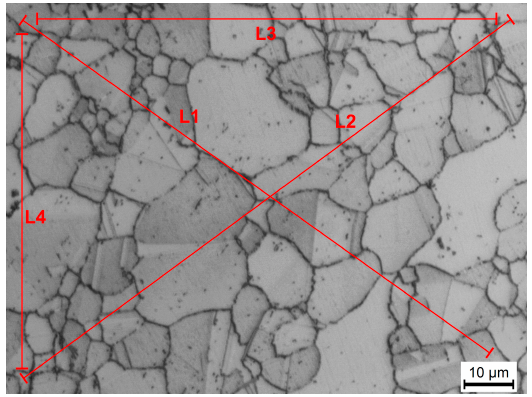
Figure 1. The representative optical microscopy (OM) image of grain size determination by the linear intercept method.